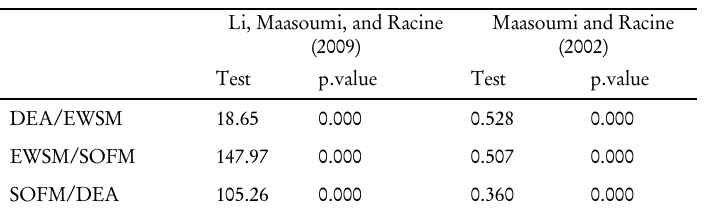
Non parametric test